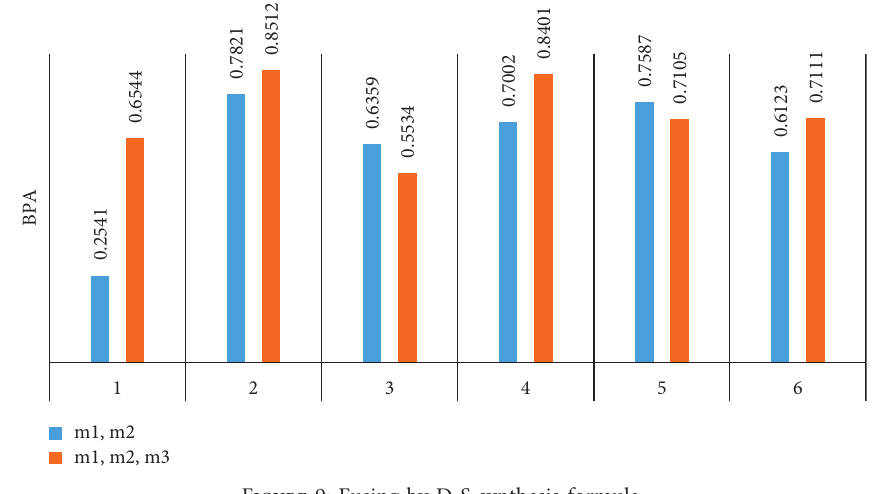
Figure 9: Fusing by D-S synthesis formula.